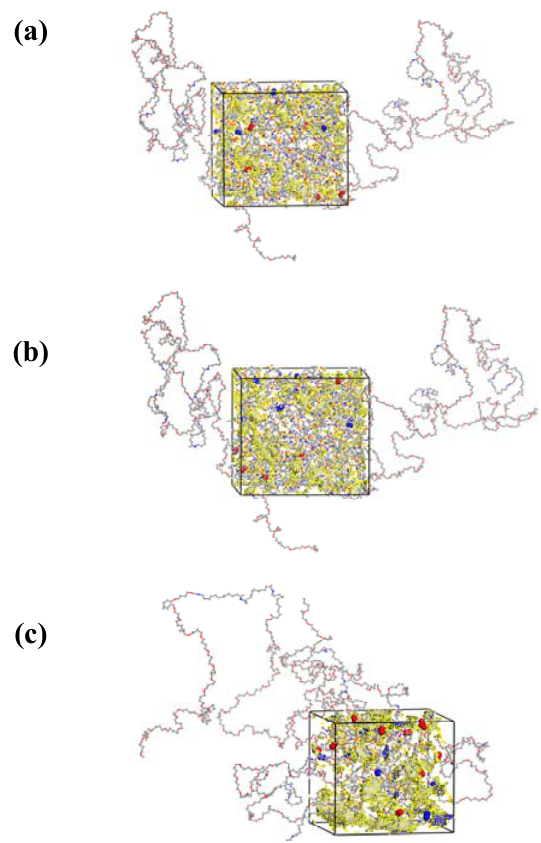
Figure 1. 3D Equilibrated simulation models of ( a ) PEBAX/30 wt % KET; ( b ) PEBAX/50 wt % KET; ( c ) PEBAX/70 wt % KET. The region of free volume inside the systems is colored in